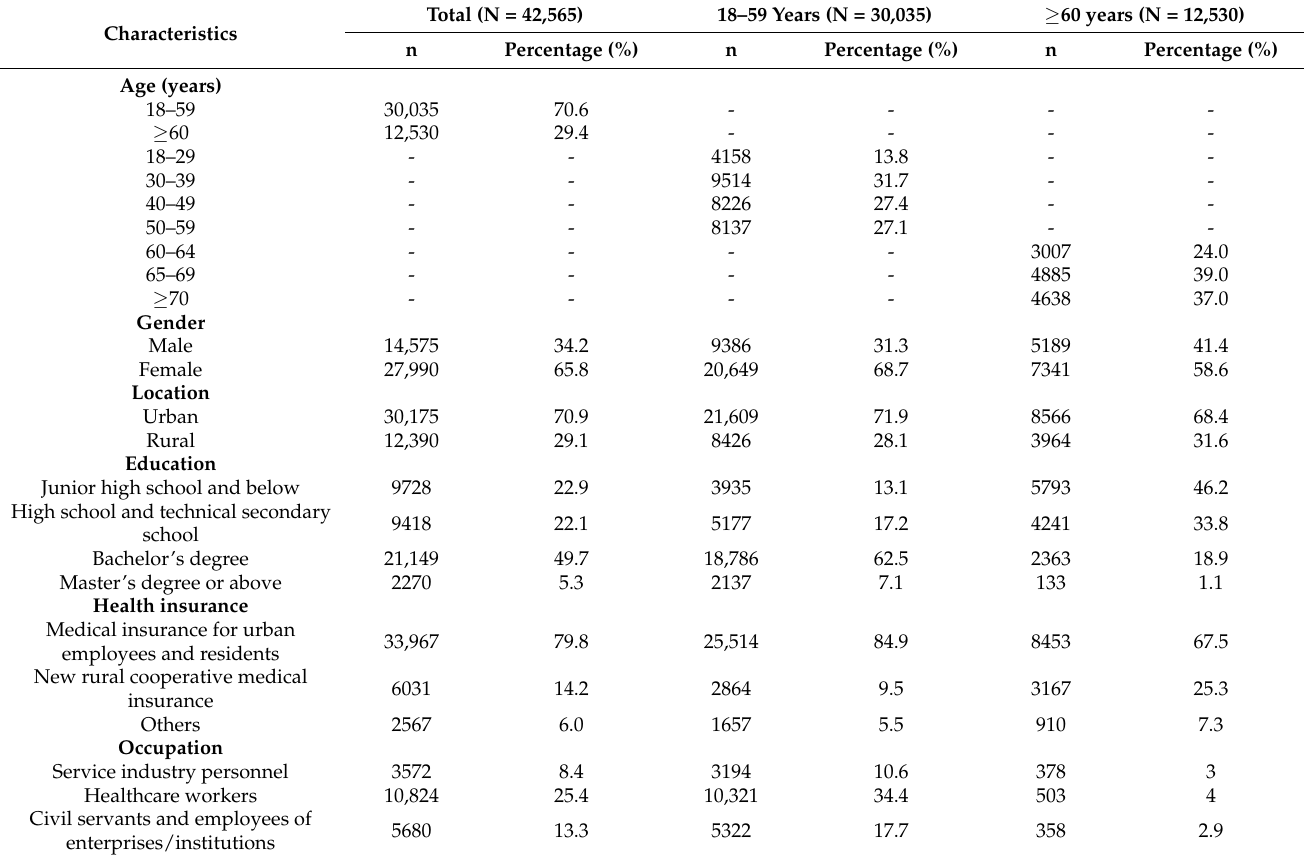
Table 1. Basic characteristics of the included study